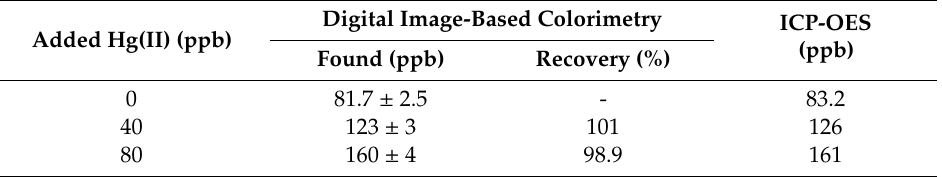
Table 2. Recovery experiments of spiked river water samples ( n =